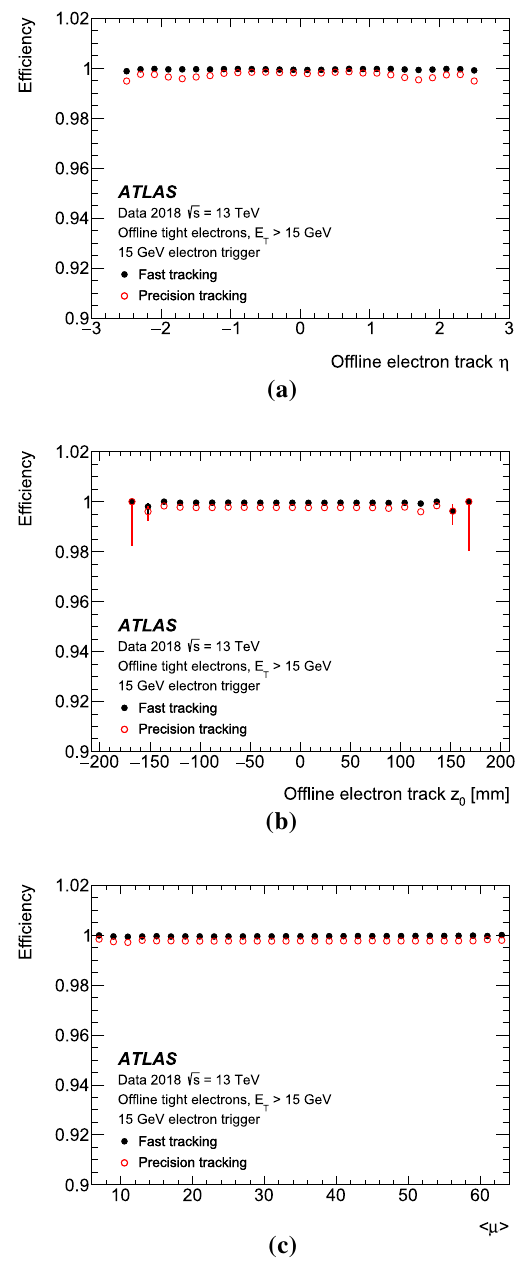
Fig. 28 The electron track finding efficiency versus a the offline elec- tron track pseudorapidity, b z position at the beam line, and c the mean pile-up interaction multiplicity measured using the dilepton trigger